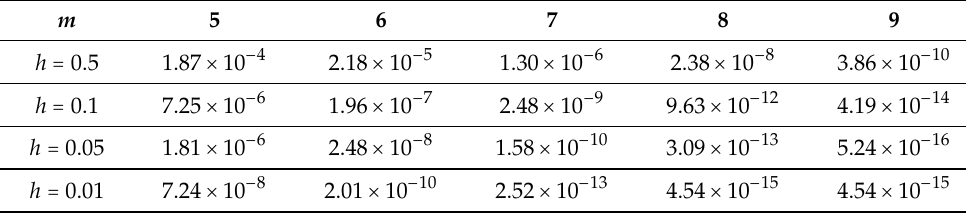
Table 5. Relative errors at